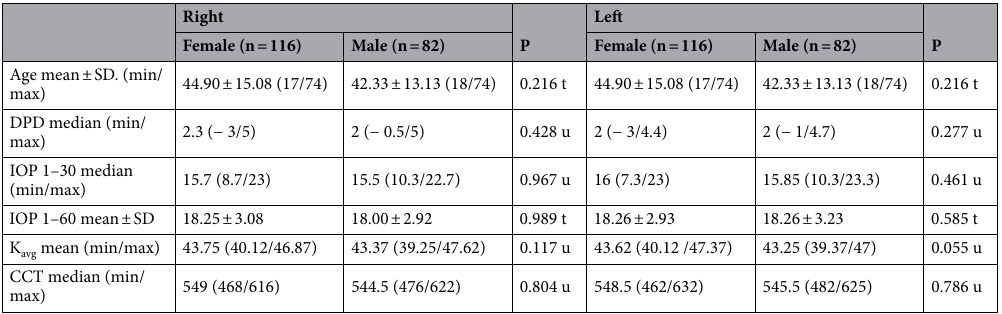
Table 3. Differences in ocular parameters between sexes. t ındependent samples T test (bootstrap), u Mann Whitney U test (Monte Carlo), SD standard deviation, min minimum, max maximum, IOP 1–30 intraocular pressure in mm Hg (1–30 mode), IOP 1–60 intraocular pressure in mm Hg (1–60 mode), DPD differential pressure difference in mm Hg, K avg average keratometric value in diopters, CCT central corneal thickness in micrometers.